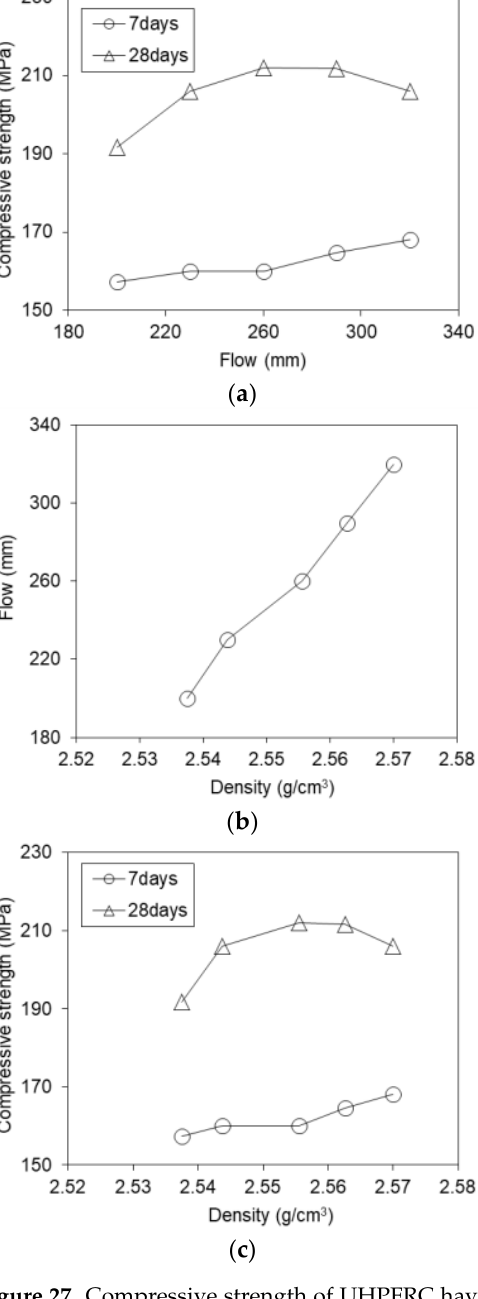
Figure 27. Compressive strength of UHPFRC having various fresh properties. ( a ) Strength — flow. ( b ) Flow — density. ( c ) Strength — density.